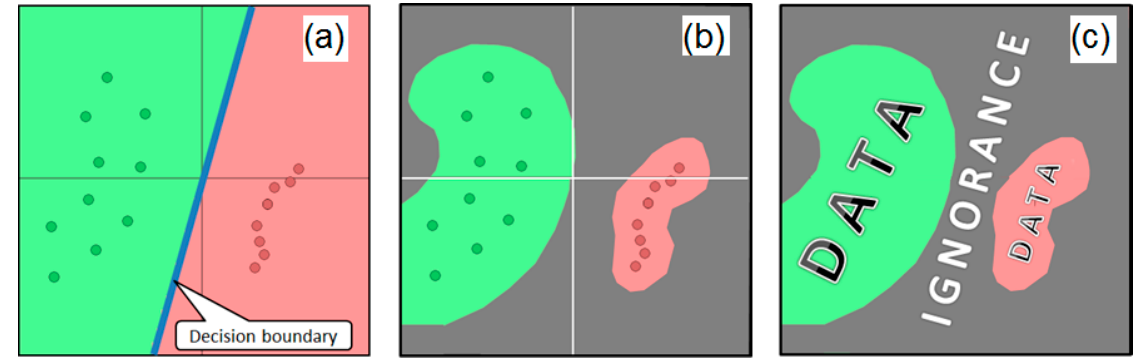
Figure 1. Supervised learning visualized: ( a ) for the Closed World Assumption; ( b ) and ( c ) for the Open World Assumption, which assumes the presence of the ignorance zones.